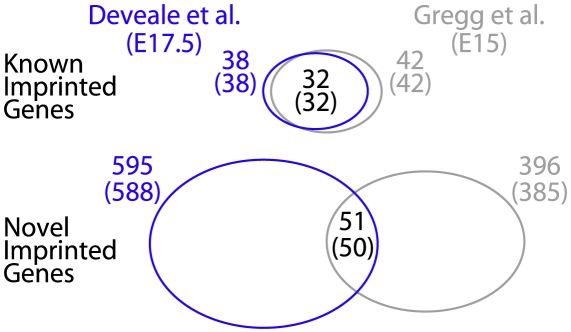
Independent replication with E17.5 brains recapitulates 76.2% (32/42, 0.1 expected by chance) known and 12.9% (51/396, 24 expected by chance) novel imprinted genes reported previously [17].12,171 (E15) and 10,418 (E17.5) genes were sufficiently powered for detection (≥1 SNP with ≥10 reads), of which 10,222 were in both samples. Reanalysis excluding SNPs detected in parental transcriptomes while relying exclusively on public SNPs marginally changes the outcome of imprint detection (numbers shown in brackets).